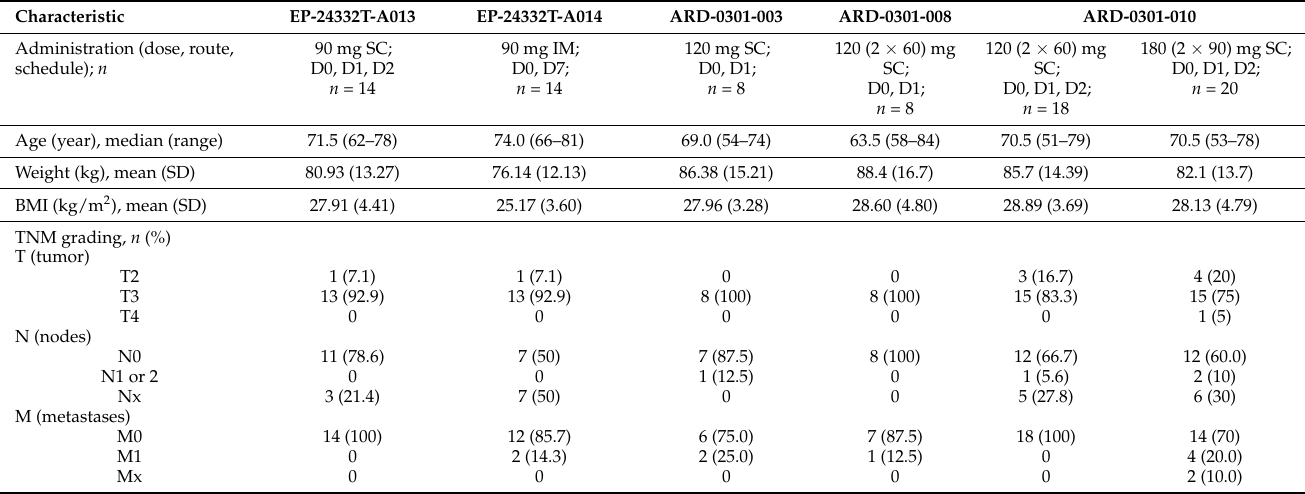
Table 1. Patient baseline characteristics (per-protocol